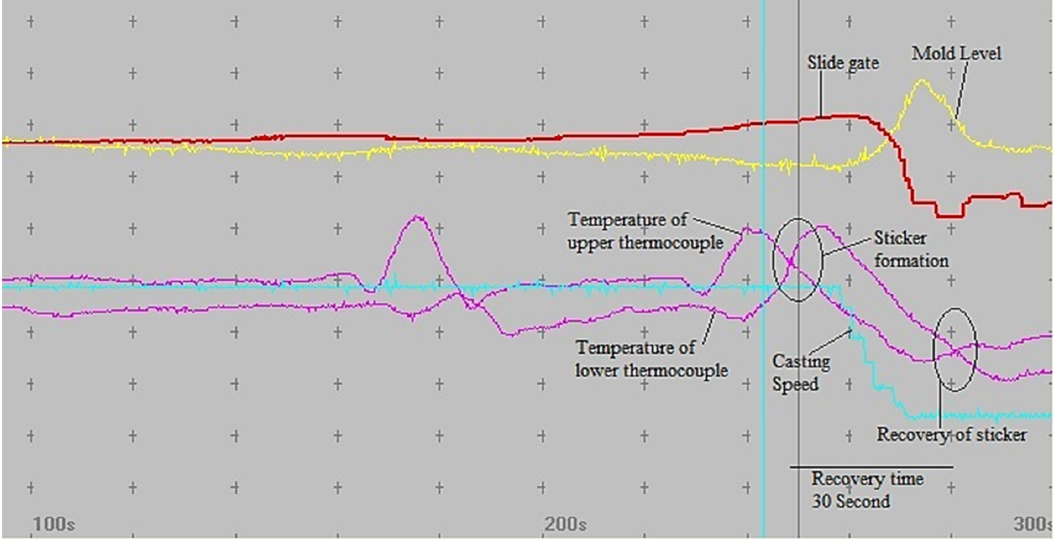
Figure 15. Representative breakout data of one field test (April 2021 to September 2021) depicting the recovery of a sticker-type breakout by reducing the casting